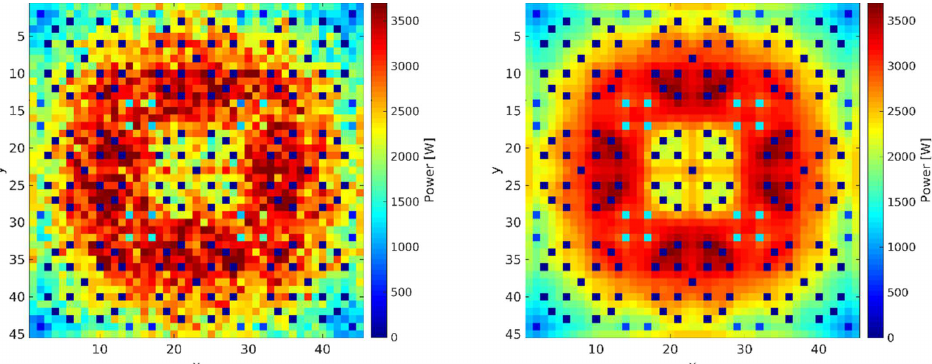
Fig. 8. Node-wise power estimates for Run #2 (left) and Run #1 (right) accumulated during the corresponding time step.